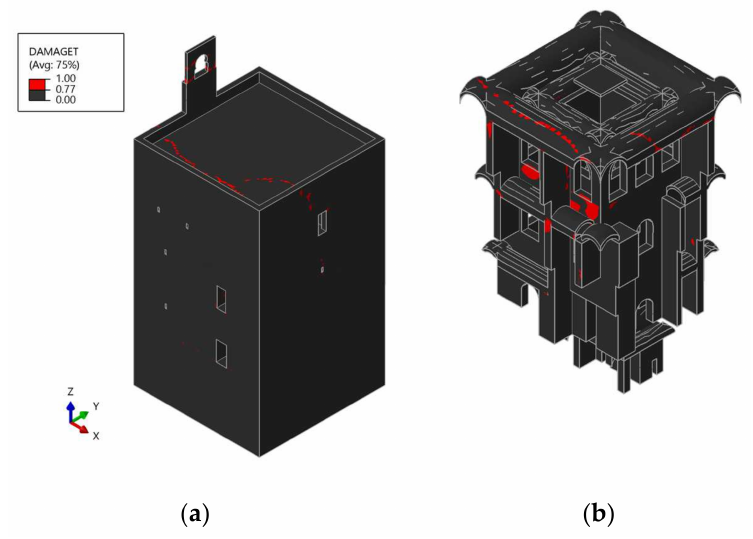
Figure 7. Damage in tension greater than 0.77: ( a ) exterior of the building; ( b ) interior of the building.